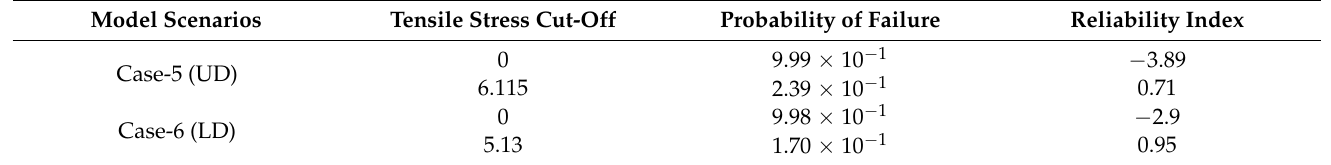
Table 4. Tensile failure and reliability index of Case-5 and -6 in different tensile stress cut-off values. Model